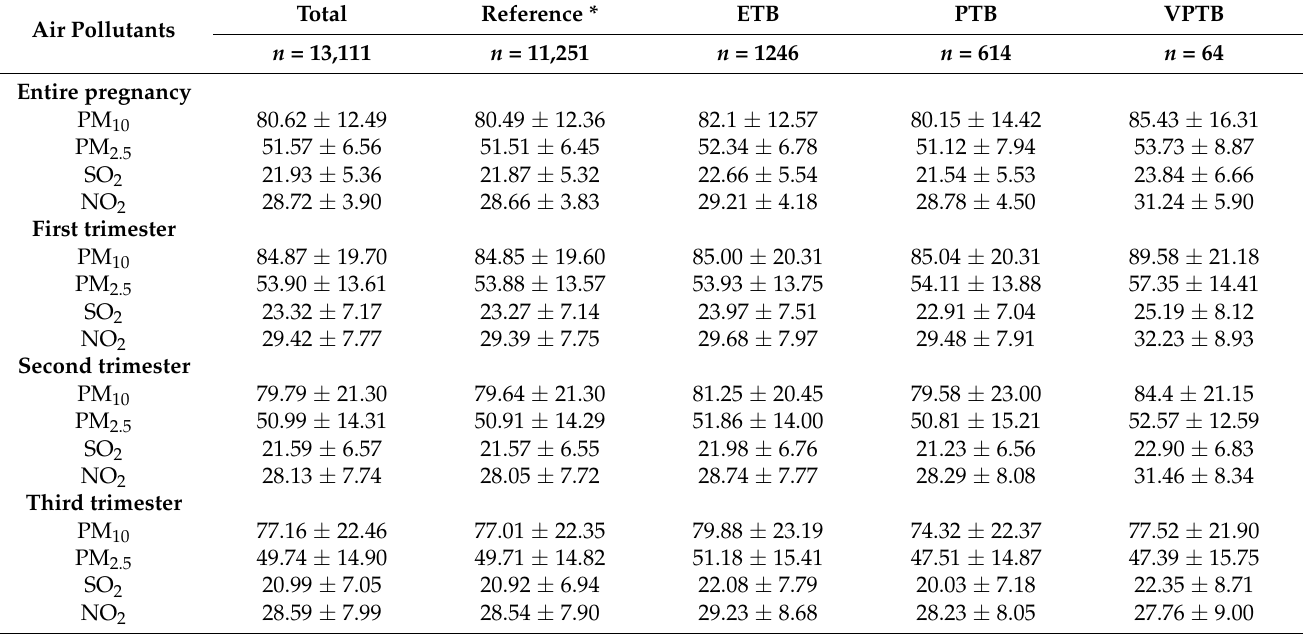
Table A1. Descriptive statistics for the mean and standard deviation of air pollution concentrations ( µ g/m 3